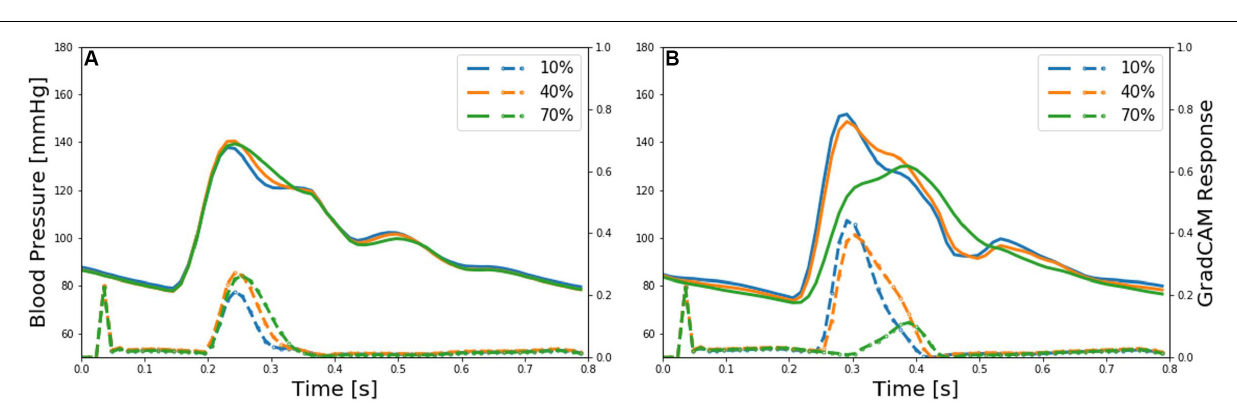
FIGURE 8 | Representative brachial and ankle pulse waveforms (solid lines) and discriminative features (dotted lines) of deep convolutional neural network (CNN) localized by the gradient-weighted class activation mapping (GradCAM) associated with low (10%), medium (40%), and high (70%) PAD severity levels. (A) Brachial arterial pulse. (B) Ankle arterial